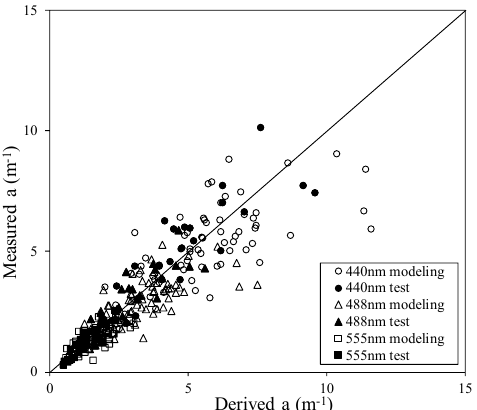
Figure 10. Comparison of improved QAA-derived total absorption coe ffi cients a( λ ) versus the measured total absorption coe ffi cients a( λ ) for wavelengths at 440, 488, and 555